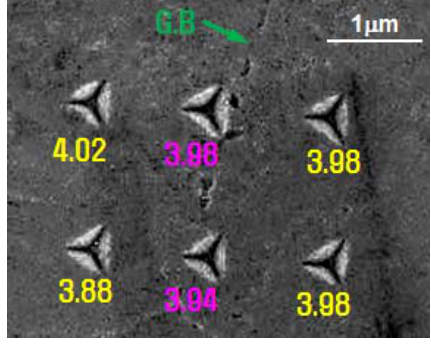
Figure 11. Nanoindentation results showing hardness at 750 °C.